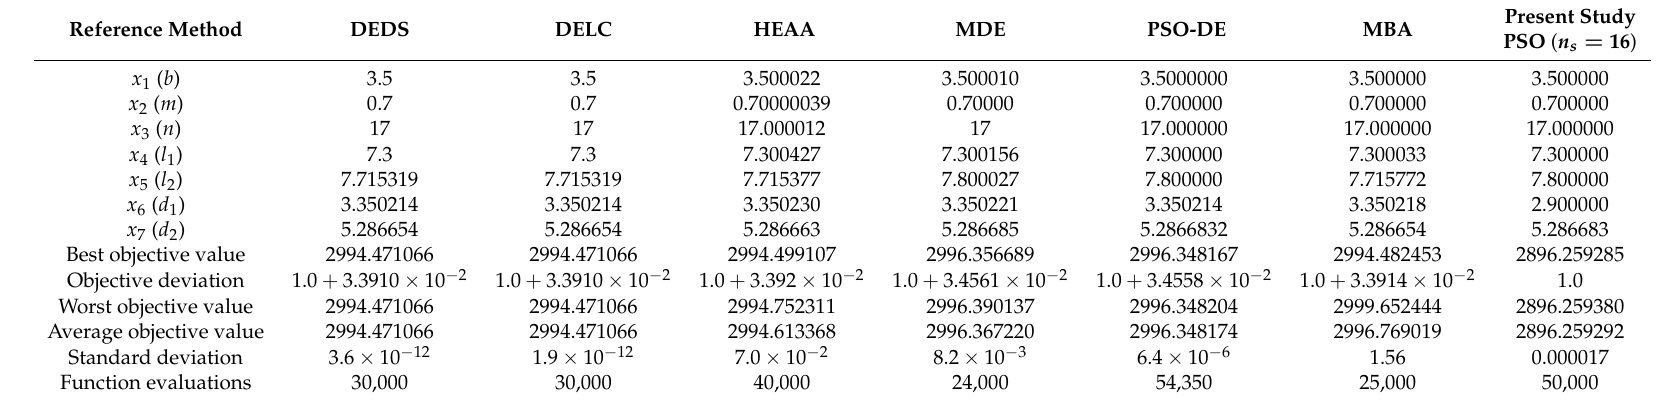
Table 9. Optimization results of the speed reducer design problem.